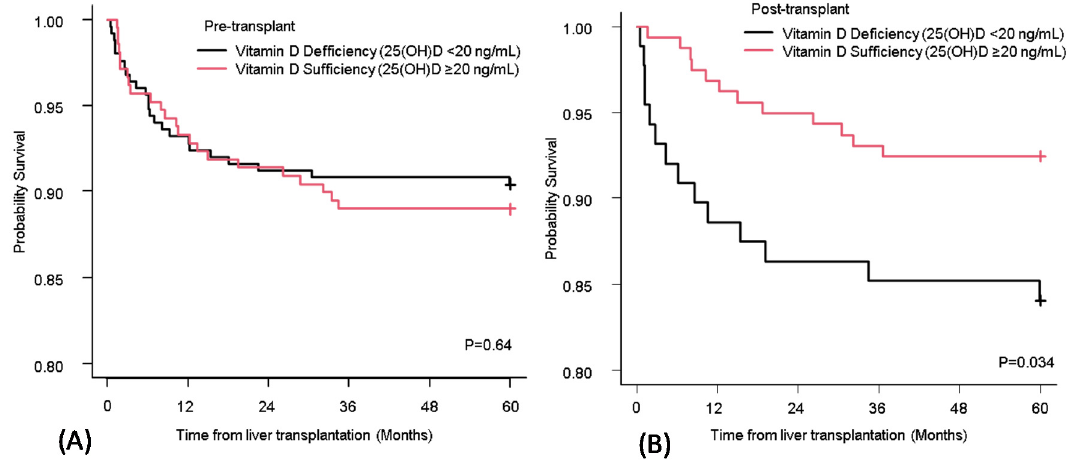
Figure 2. OS of recipients who had vitamin D deficiency and sufficiency at pre-transplant ( A ) and post-transplant ( B ). The Kaplan–Meier curve for OS of recipients who had vitamin D deficiency (black line) and sufficiency (red line). Vitamin D deficiency was defined as <20 ng/mL of the serum level of 25(OH)D. OS: overall survival; 25(OH)D: 25-hydroxy vitamin D. Table 3. Cox regression analysis of prognostic factors associated with overall survival.